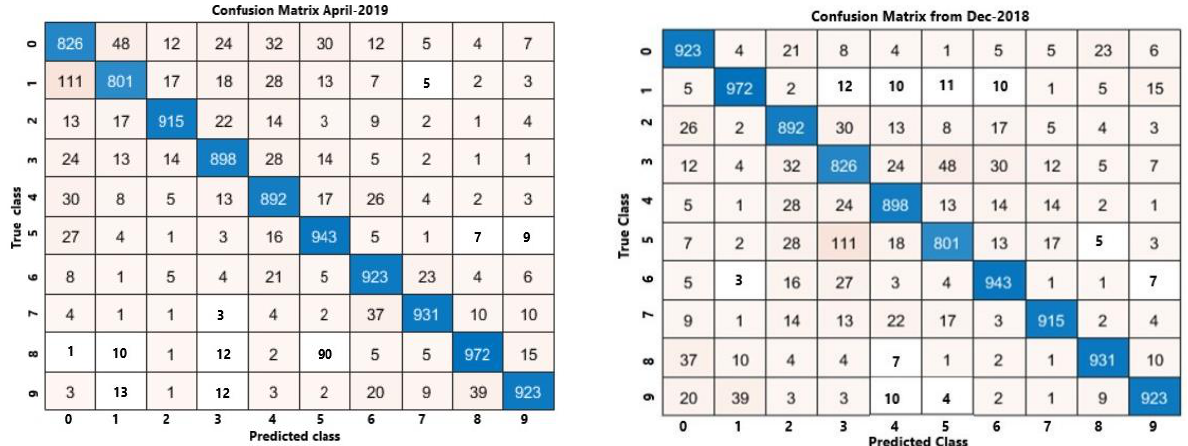
Figure 13. Accuracy vs. long epoch and loss illustration in December 2018.